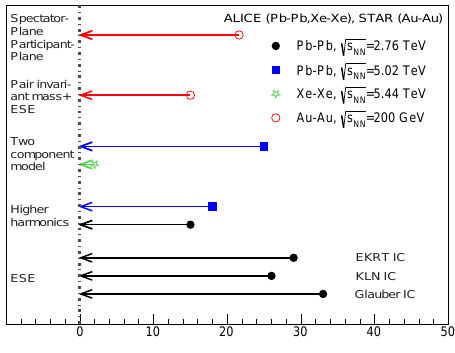
Figure 3: Summary of the results for the CME limit obtained from di ff erent analyses per- formed at various LHC and RHIC energies and colliding systems integrated over centralities. Data points are from [28, 30, 34, 37,